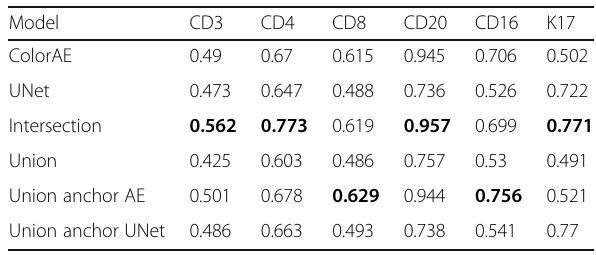
Table 4 Positive Predictive Value (Precision) evaluating predictions from UNet, ColorAE, and ensemble methods against dilated seed